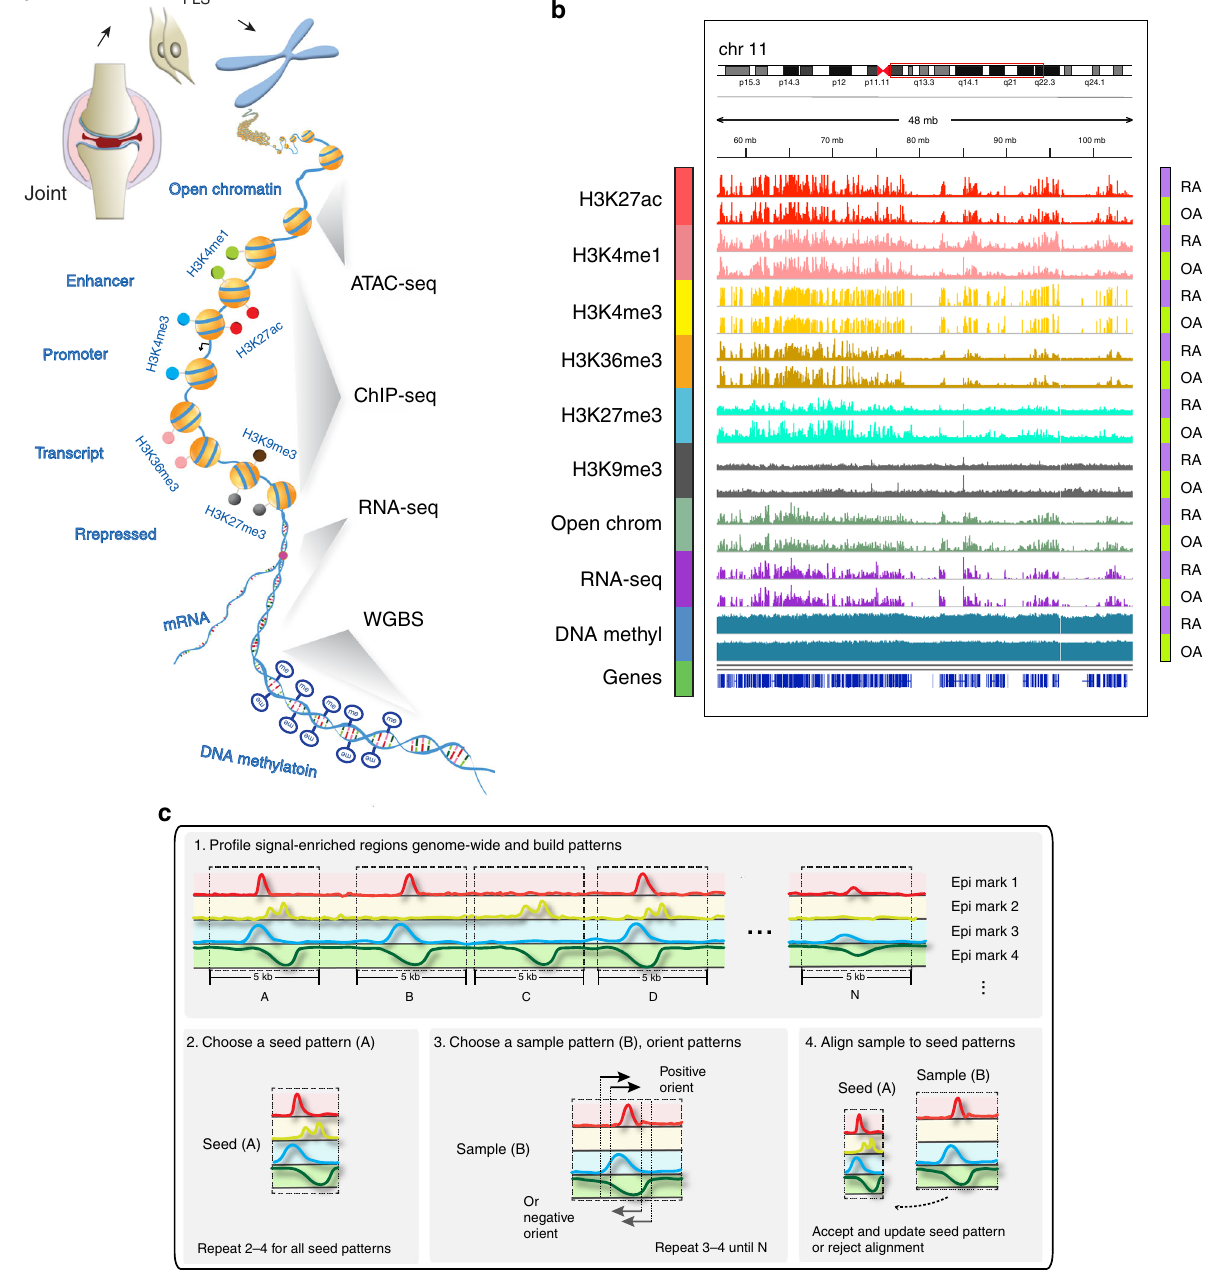
Fig. 1 Overview of RA integrative analysis pipeline. a Schematic representation of major omics methods used in RA FLS. b Epigenomic landscape of RA FLS with six histone modi fi cations, open chromatin, RNA-seq and DNA methylation. The fi gure shows an example of the relative signal intensity across a selected region of the genome for each mark in RA and OA FLS. In addition, the locations across chromosomes for the selected regions are indicated. c Schematic overview of how EpiSig integrates different epigenetic marks. The algorithm detects signi fi cant signals from sequencing data in 5 kb genome regions, clusters regions based on similar epigenomic patterns, and identify epigenomically similar